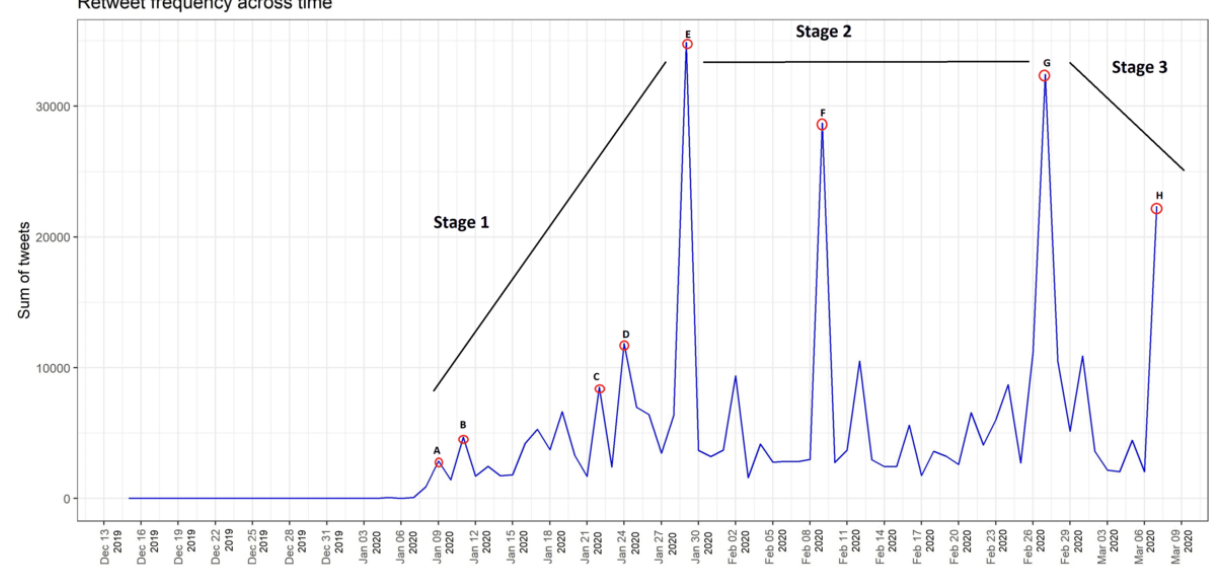
Figure 1. Frequency of retweets regarding the COVID-19 pandemic from December 13, 2009, to March 9, 2020. (A) A novel coronavirus was isolated; (B) the first fatal case was reported; (C) the first case of COVID-19 in the United States was confirmed; (D) 835 cases were reported in China; (E) the World Health Organization (WHO) declared a public health emergency of international concern; (F) the WHO announced the name “COVID-19”; (G) infections spiked in Italy and the rest of Europe; (H) the number of COVID-19 cases surpassed 100,000.